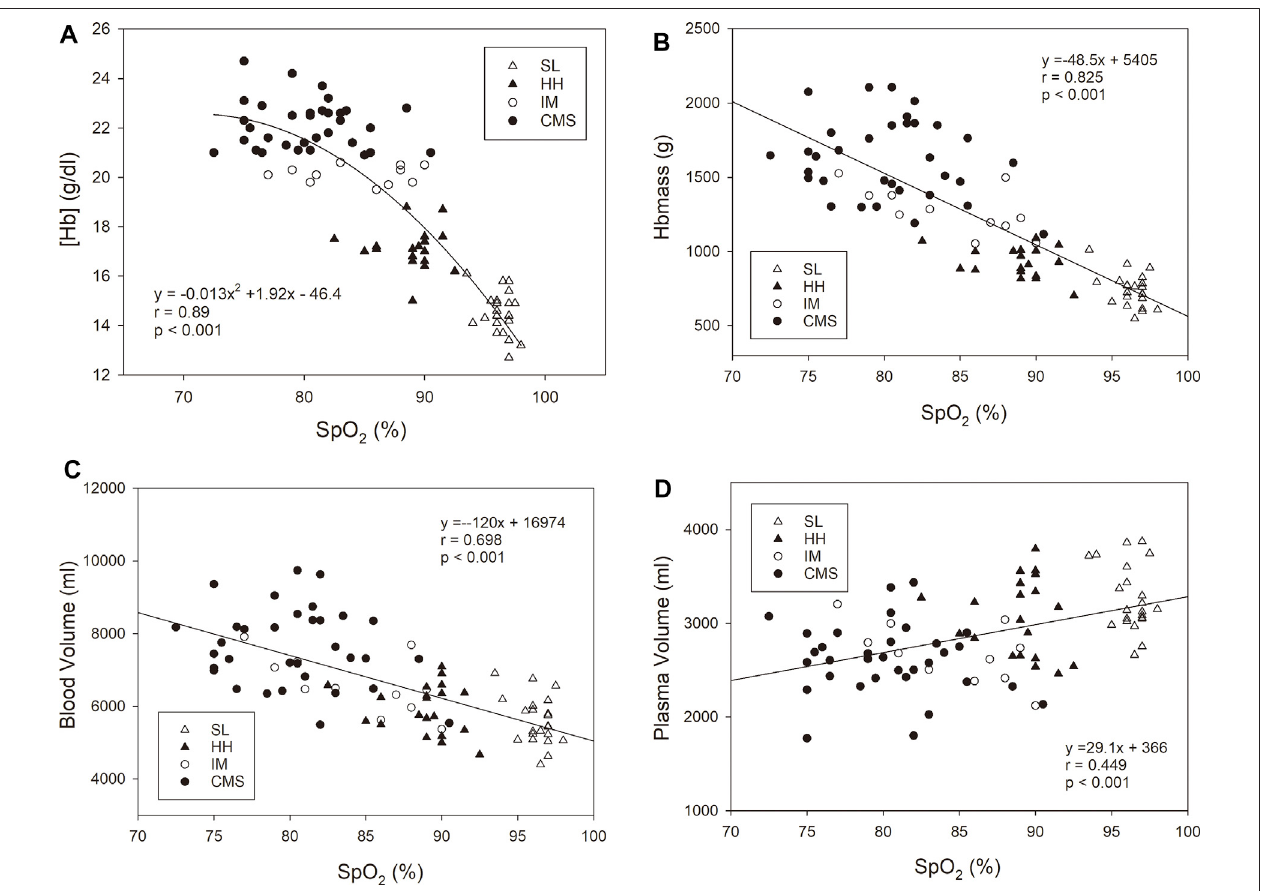
FIGURE2| Oxygensaturationinarterializedblood (SpO 2 )vs.hemoglobinconcentration[Hb], (A) ,hemoglobinmass(Hbmass), (B) ,blood volume (C) ,andplasma volume (D) . The statistical information relates to the entire cohort. The regression analyses within the subgroups did not yield any signi fi cant relationship.